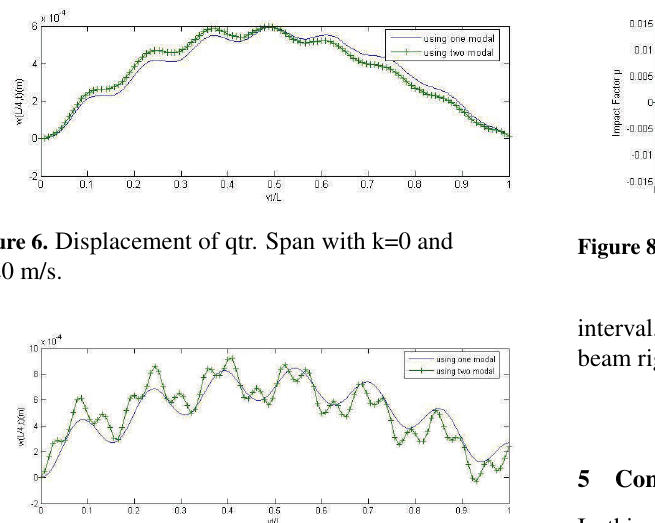
Figure 7. Displacement of qtr. Span with k=0.25 and v=20 m/s.